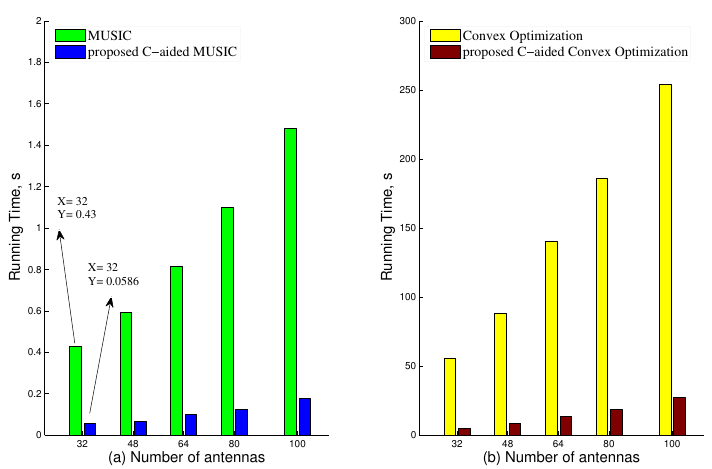
Figure 4. Running time comparison versus different number of antennas ( M AI = M AII = 500,SNR = 20